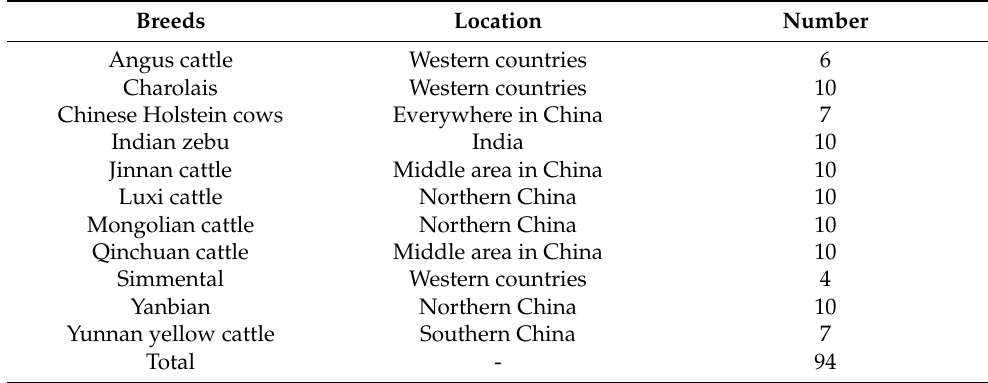
Table 1. The mtDNA D-loop sequences downloaded from the NCBI database were used for multi- sequence alignment and NJ tree